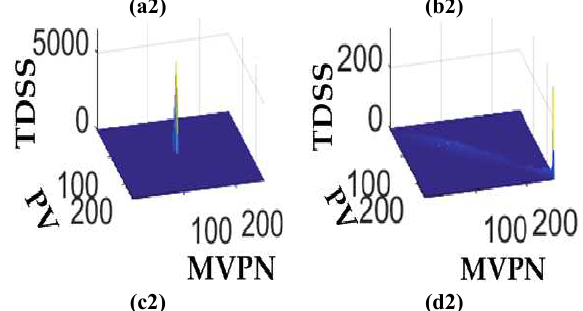
Figure 2. The plane and geometrical mapping models of experimental images with different types: (a-d) experimental images; (a1-d1) planar scatterplot mapping model; (a2-d2) geometrical space mapping model.